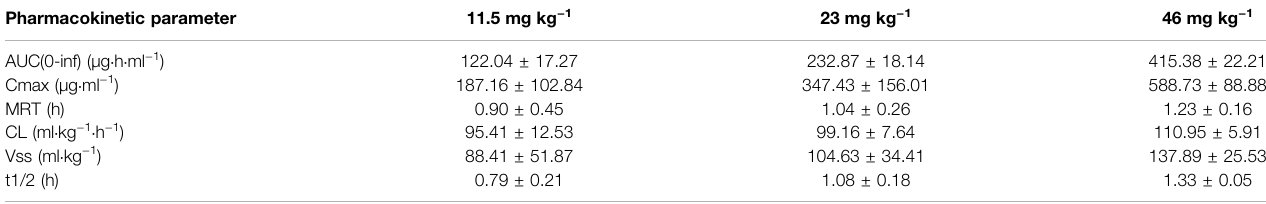
TABLE 1 | Pharmacokinetic parameters of MK-ASODN nanoliposomes following intravenous administration at doses of 11.5, 23 and 46 mg kg − 1 to macaque monkeys ( n (cid:1) 3). Pharmacokinetic parameter